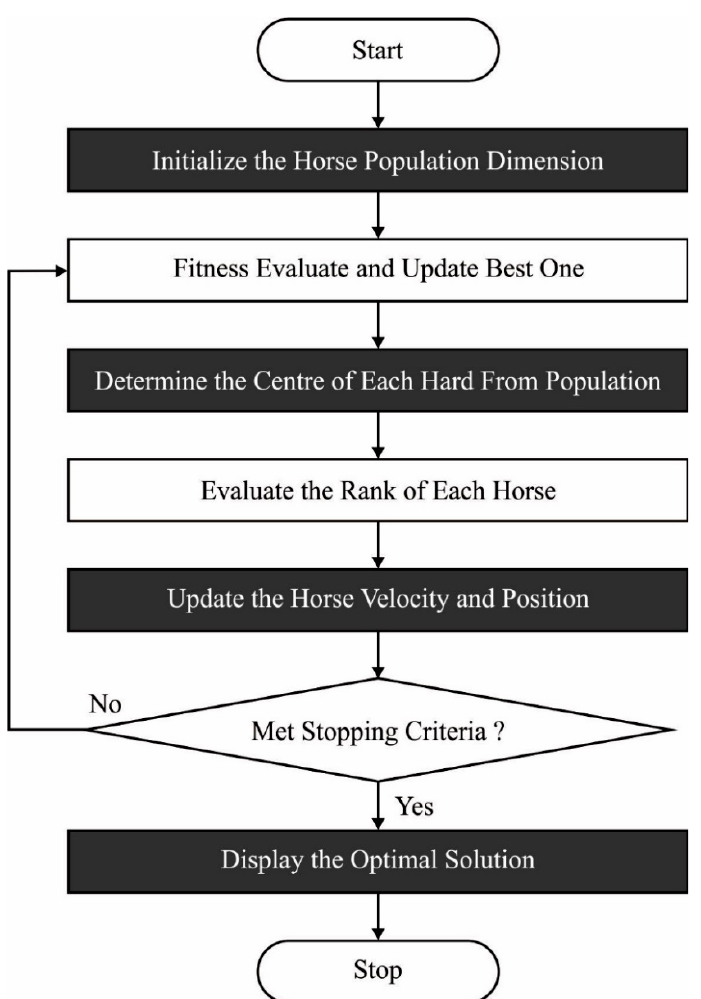
Figure 2. Flowchart of WHO algorithm.